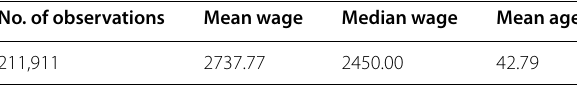
Table 1 Summary statistics SOEP-Pure 1 sample Table 2 Summary statistics SOEP-Pure 2